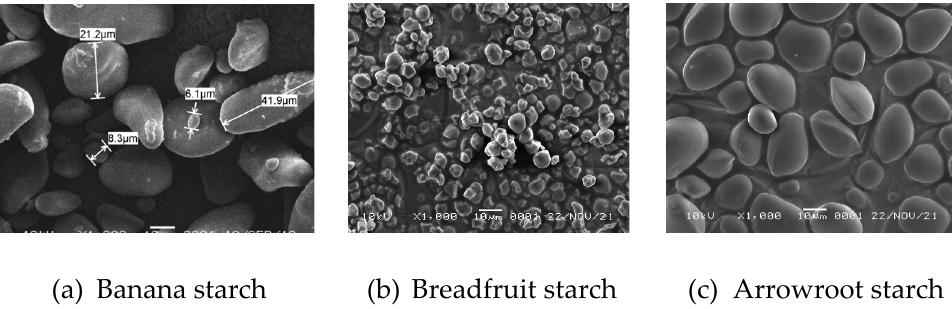
Figure 1. SEM images of native banana, breadfruit and arrowroot starches (1000 × magnification).